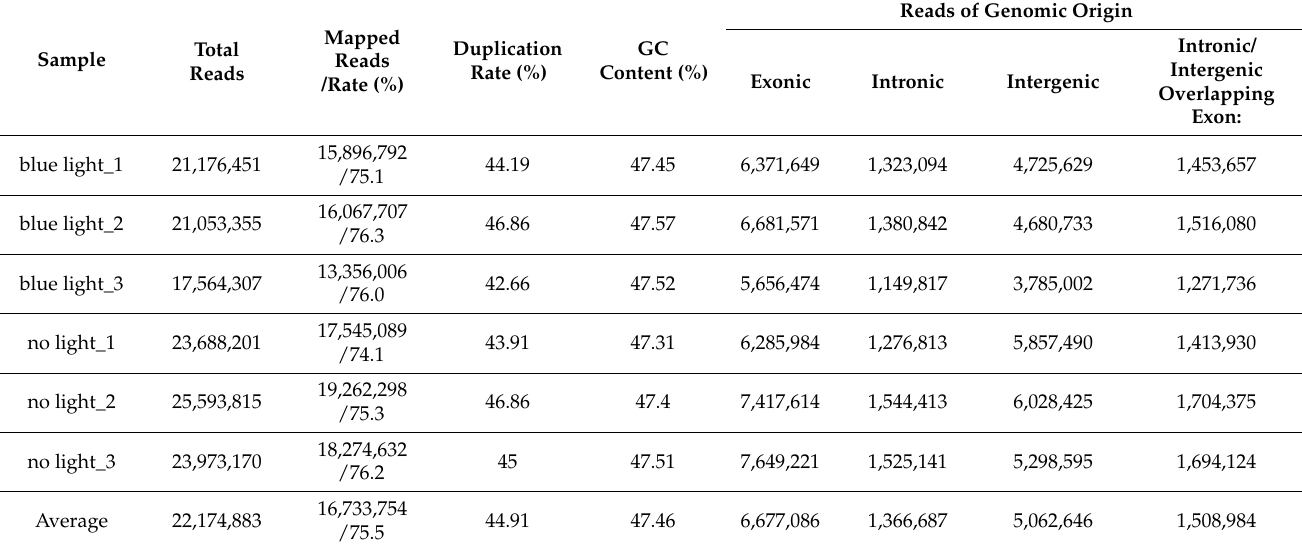
Table 2. Summary of sequencing and mapping results.